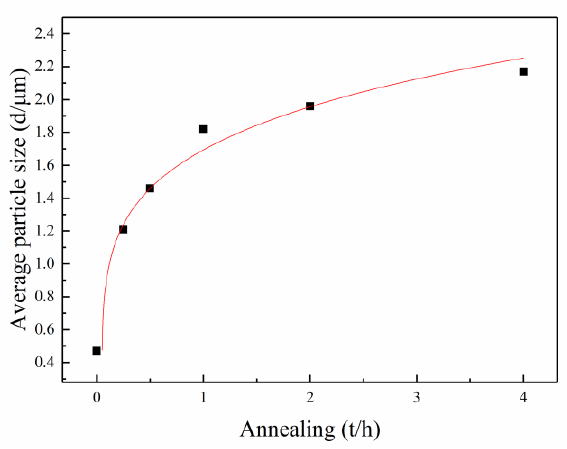
Figure 8. Variation of eutectic Si length with annealing time in Al-14.5Si alloy.